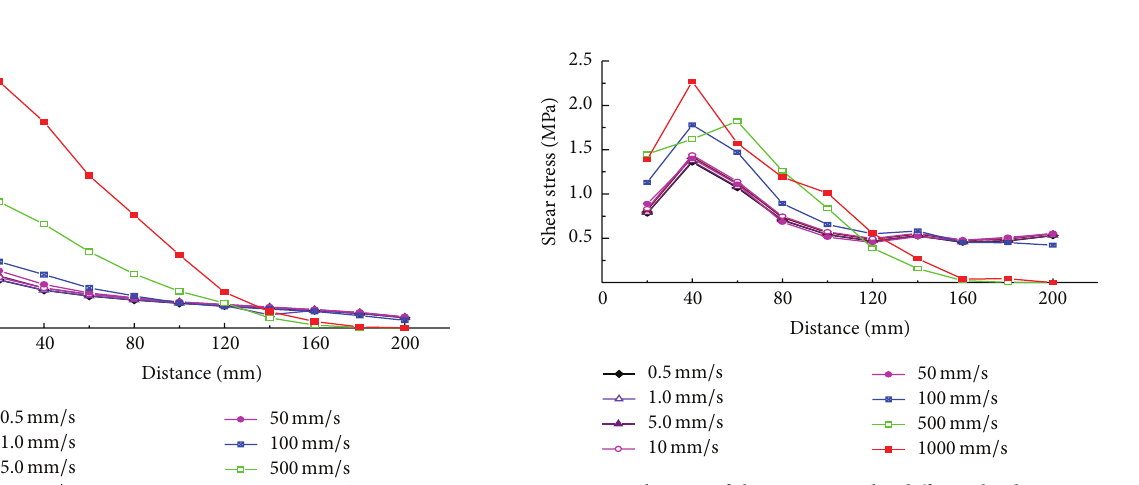
Figure 9: Changes of shear stress under different loading